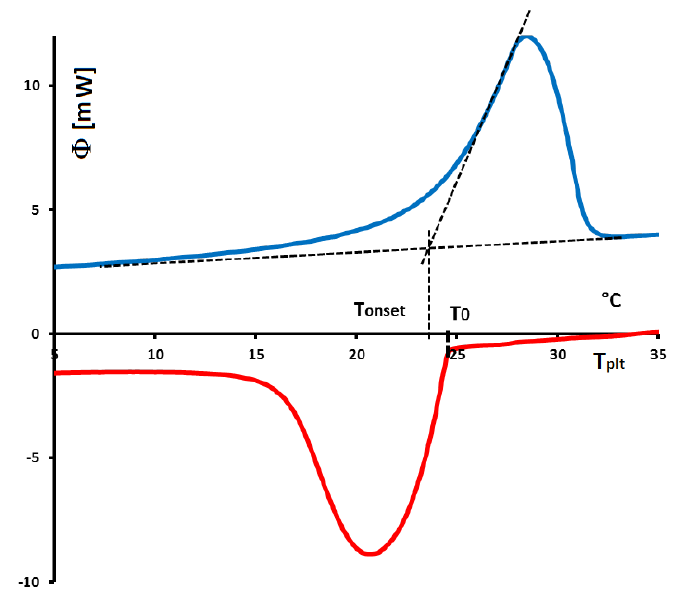
5 K/min (red curve) and at the heating at −